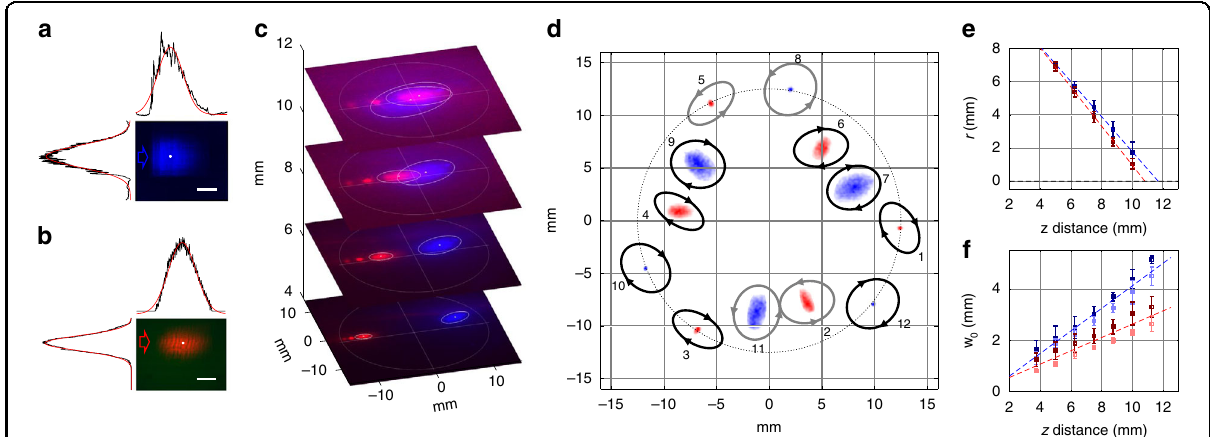
Fig. 3 Measured MOT beam performance. a Image of a blue 45° beam, showing integrated power pro fi les projected along the horizontal and vertical directions along with Gaussian fi ts (red curves). b Image of a red 45° beam, showing beam pro fi les and Gaussian fi ts (red curves). Scale bar for all panels is 100 µm. Arrows depict the direction of the slab-mode beam incident on the grating. c Images of one red and one blue 45° beam taken at different heights above the chip. The red light has three diffraction orders visible, positive (left), zero (center), and negative (right, circled). d Map of the twelve beams measured at ≈ 4 mm above the MS. Overlayed with each beam is the optical fi eld polarization measured normal to the beam propagation direction and plotted here as ellipses in the chip plane with right-handed circular polarization (black) and left-handed circular polarization (gray) indicated. In all ( a – d ) the image intensities have been rescaled from unsaturated images for best viewing of the beam shapes and trajectories. A complete data set of unsaturated images are provided in Fig. S3. e Average radial position of the red and blue 45° beams at different heights. Error bars correspond to the standard deviation of the three measured beams. f Measured cross-sectional w 0 for the red and blue 45° beams with light and dark colors corresponding to w 0 along the azimuthal and radial directions, respectively. Error bars correspond to the standard deviation of the three measured